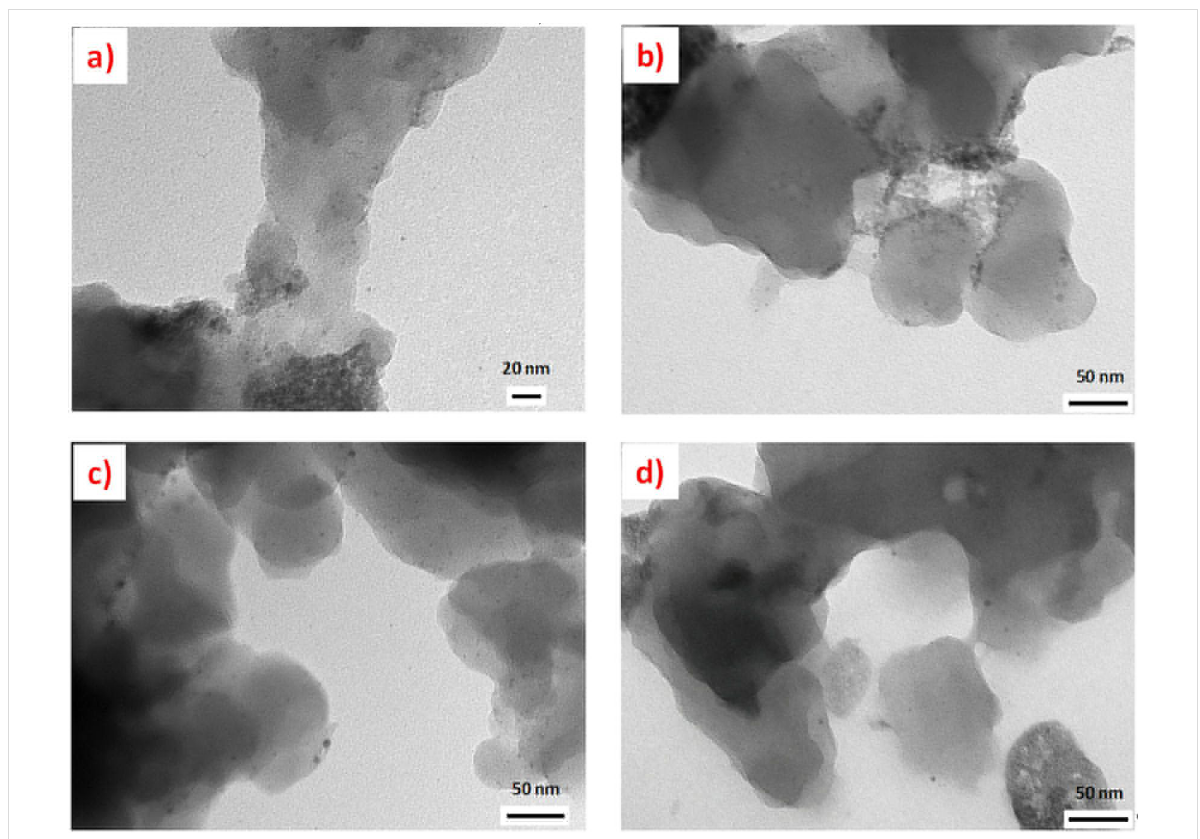
Figure 5: TEM images of the polymers after the Negishi reaction between 5 and 6 . a) 8a , bar scale 20 nm, PdNP size distribution 4.91 ± 1.26 nm. b) 8a + 9a , bar scale 50 nm, PdNP size distribution 4.23 ± 1.65 nm. c) 8a + 9b , bar scale 50 nm, PdNP size distribution 3.61 ± 1.36 nm. d) 8a + 9c , bar scale 50 nm, PdNP size distribution 3.23 ± 0.81